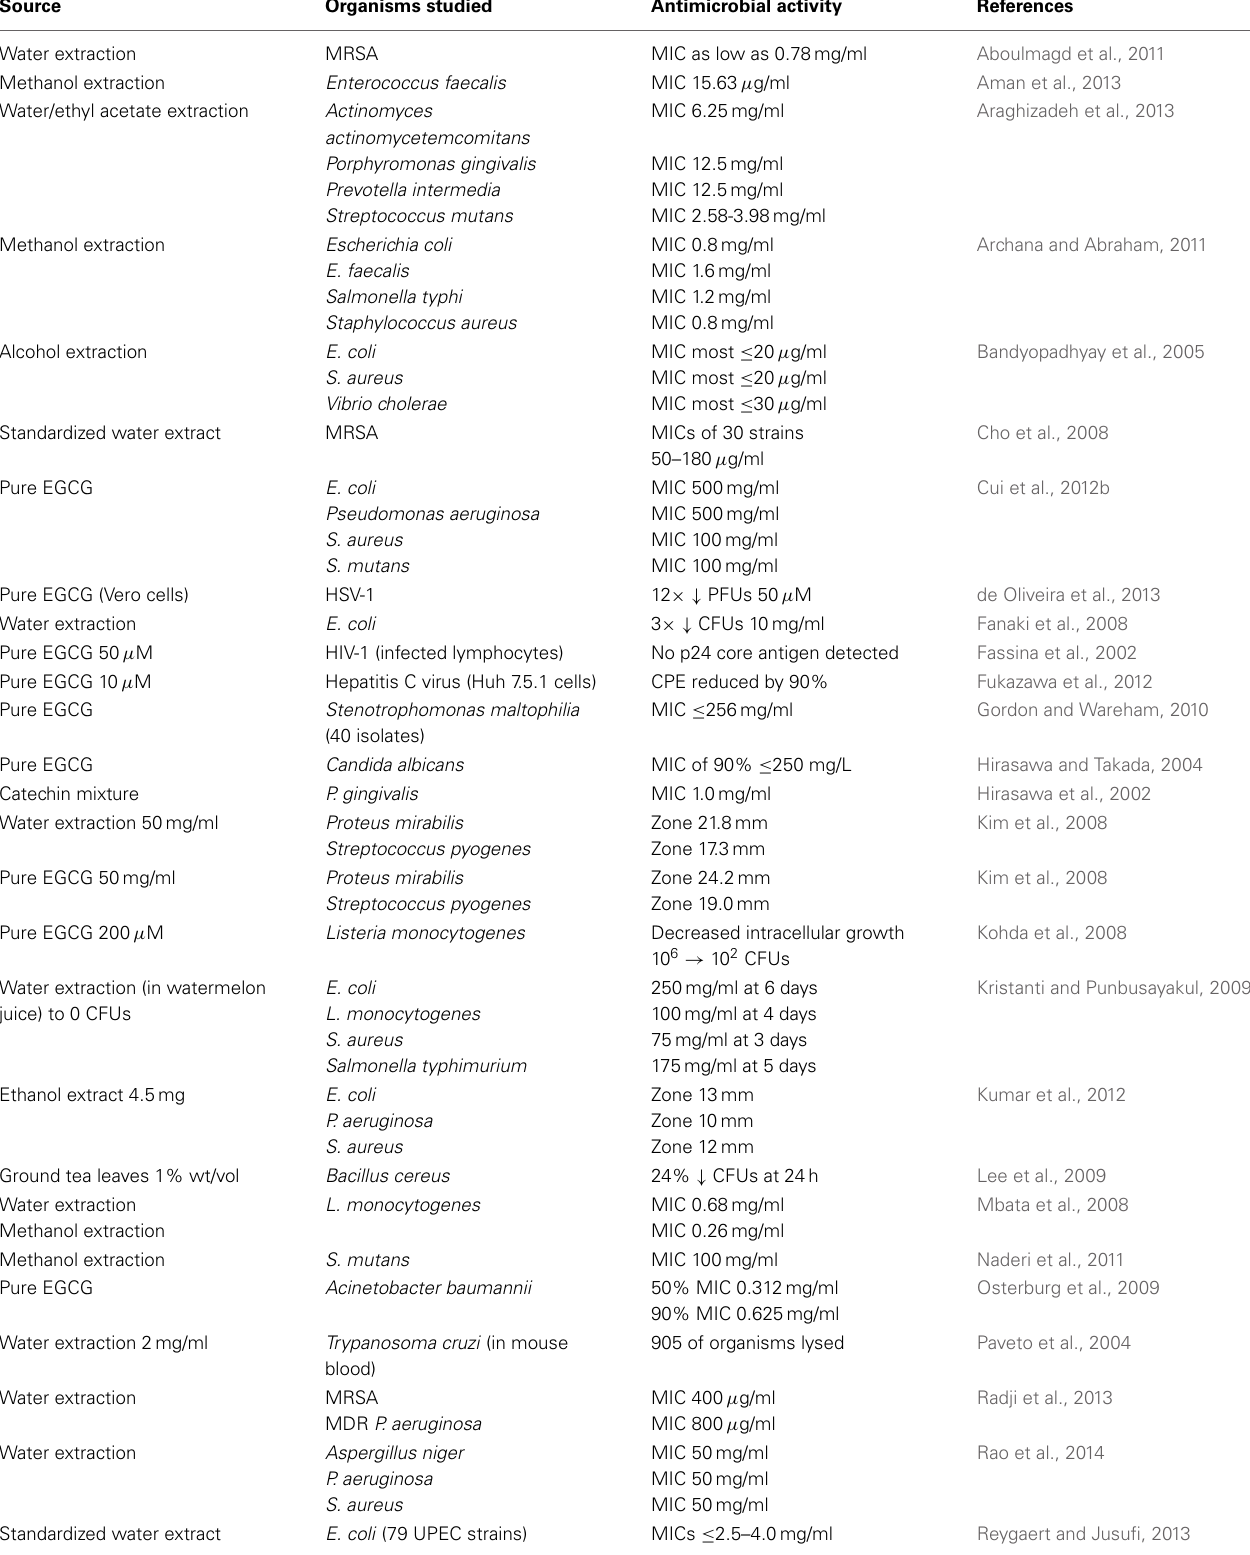
Table 2 | Antimicrobial activity of green